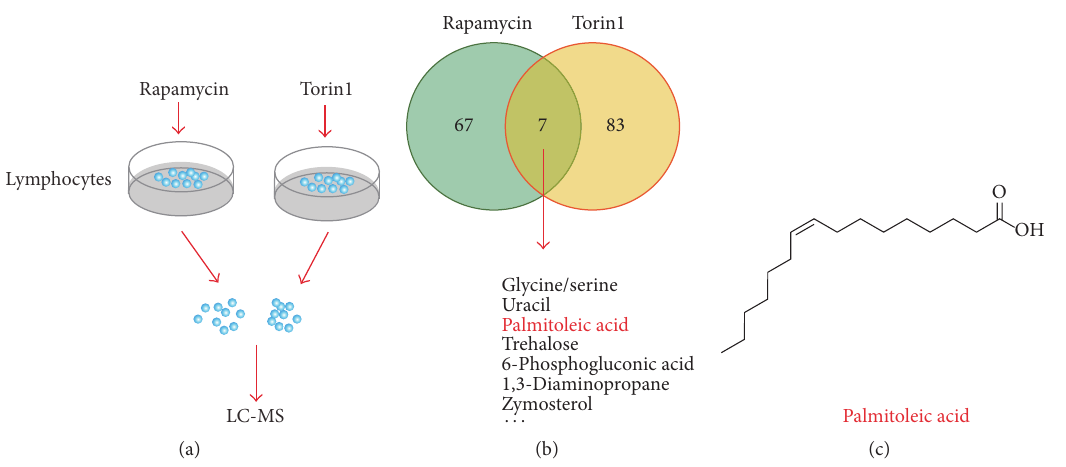
Figure 1: Screening of altered metabolites controlled by mTORC1 signaling. (a) A model showing the procedure of human PBMC cell culture and drug treatment. Rapamycin (100 nM) and Torin1 (200nM) treatment time is 24h. (b) A diagram showing the results of metabolites screening.NotethatthecrossingoftherapamycinandTorin1groupscontainsabout7substrates,includingpalmitoleicacid.(c)Themolecular structure of palmitoleic